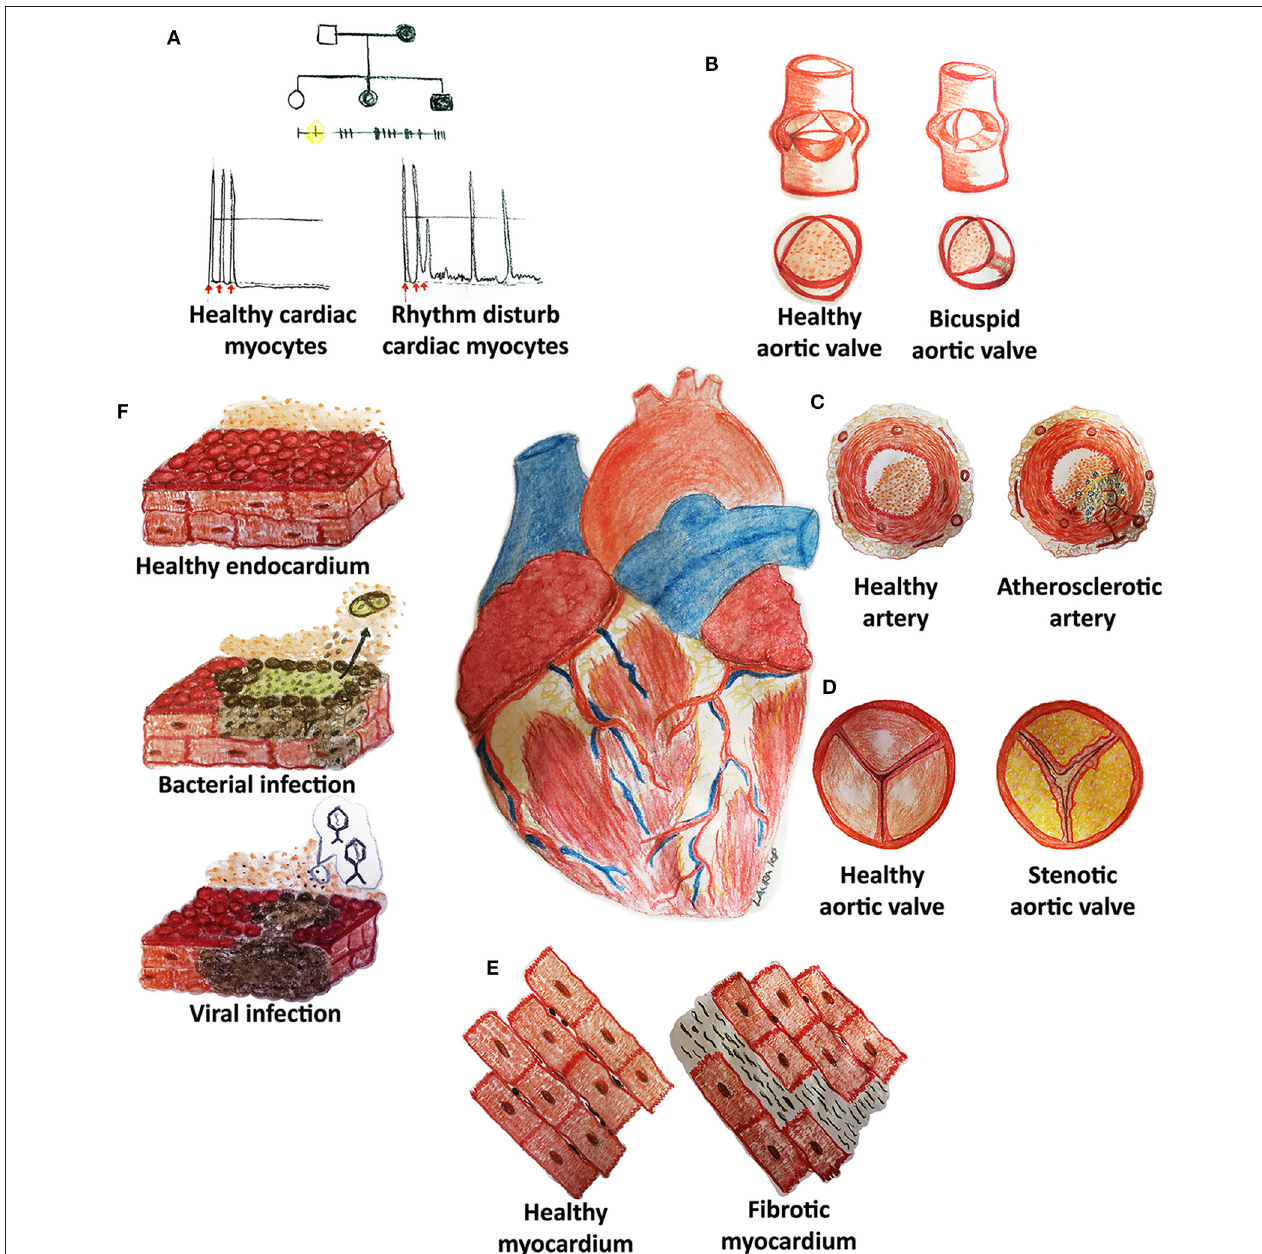
FIGURE 1 | Cardiovascular diseases (CVDs) may affect pediatric and adult patients with congenital (A,B) and acquired (C–F) pathologies of the heart and its system. (A) Rhythm disturbances are caused by mutations of genes codifying, for example, for proteins pivotal in cell electrical activity. (B) Bicuspid aortic valves derive from the fusion of two of the three cusps: genetic causes are still not clear although hemodynamic impairment is well-known. (C) Atherosclerotic arteries are frequently reported in adult patients and are characterized by an accumulation of lipids (cholesterol), inflammatory cells, endothelial, and smooth muscle cell dysfunction with embolization risks. (D) Stenotic heart valves display a fibrocalcific degeneration similar to atherosclerosis. (E) Fibrosis may develop in each cardiovascular structure (myocardium, arteries, heart valves) through inflammation and increased collagen deposition. (F) Cardiac infections may originate from bacterial or viral contaminations and might cause cell dysfunction and death, thrombi (detachment of dead cells) and other adverse